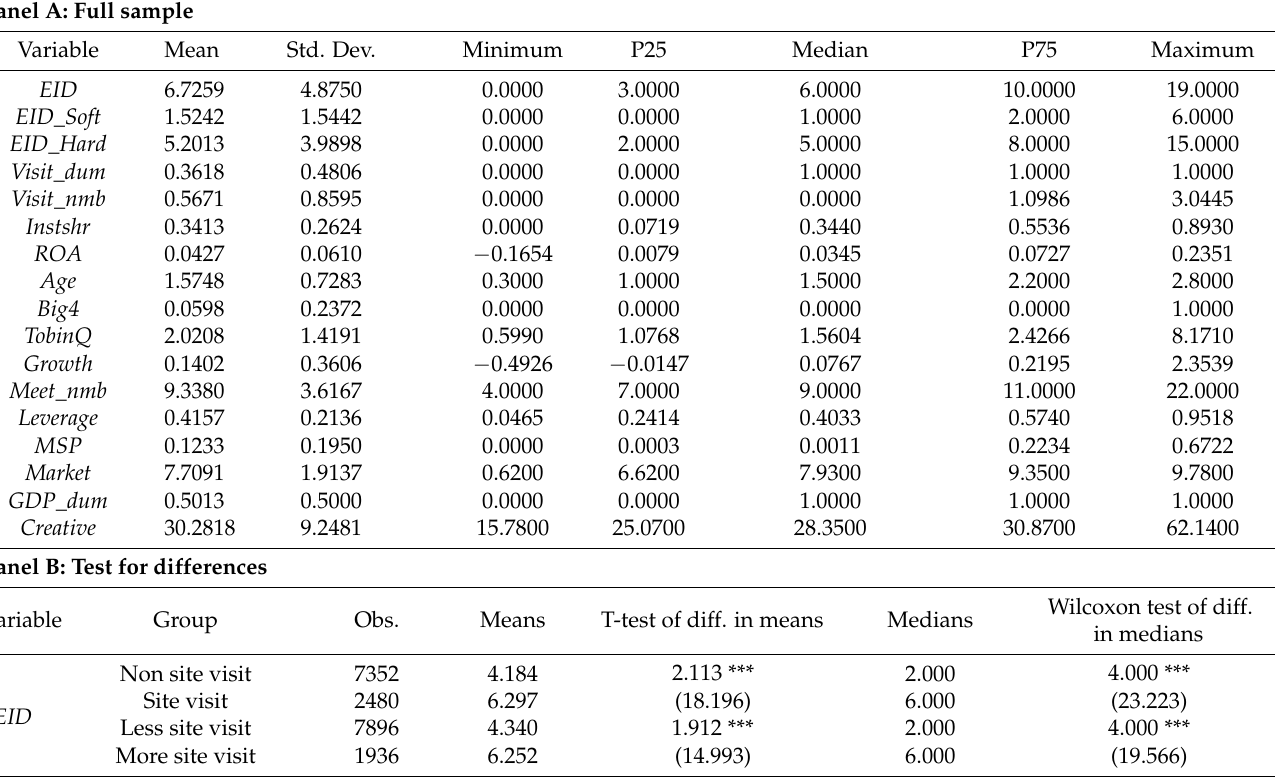
Table 2. Descriptive